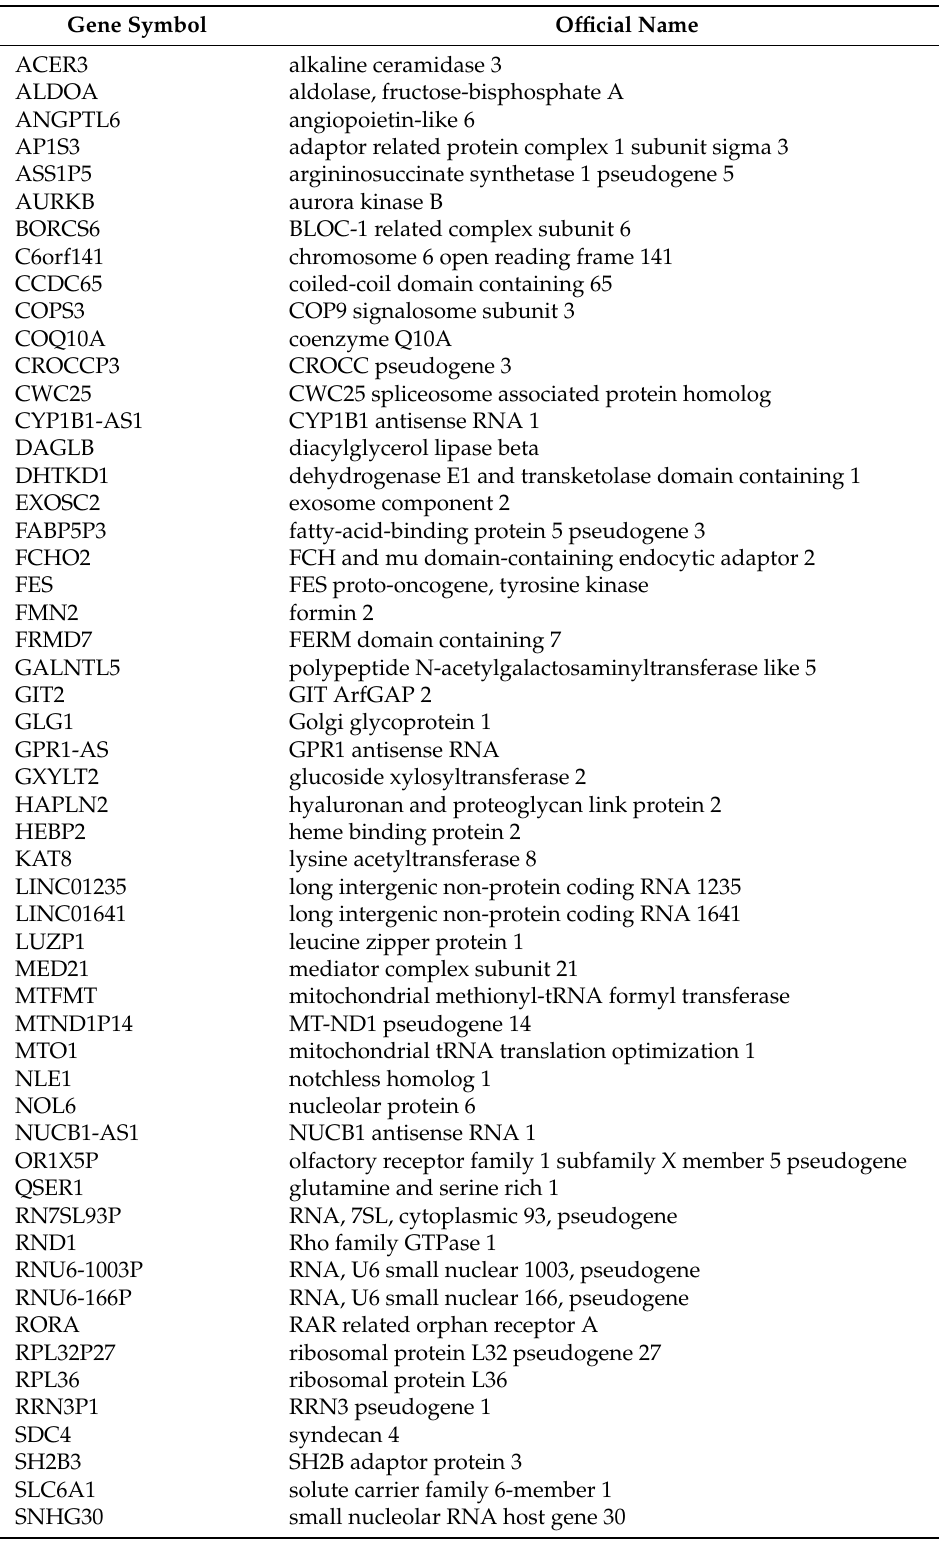
Table 4. List of predicted ZNF433 target genes identified using the GSEA Molecular Signature Database. These are genes containing one or more binding sites for UniProt: Q8N7K0 (ZNF433) in